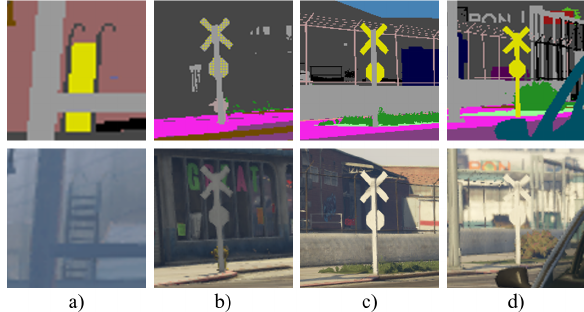
Figure 7. Examples of inconsistencies in the traffic sign labels of different datasets. Top row: Semantic ground truth images (yellow: traffic sign , gray: pole ), bottom row: Corresponding synthetic RGB images: a) Ladder labelled as traffic sign , b) Varying class labels for one sign, c) and d) Both cases show the same traffic sing; pole one time labelled as pole , the other time as traffic sign ; backside of the traffic sign labelled as traffic sign